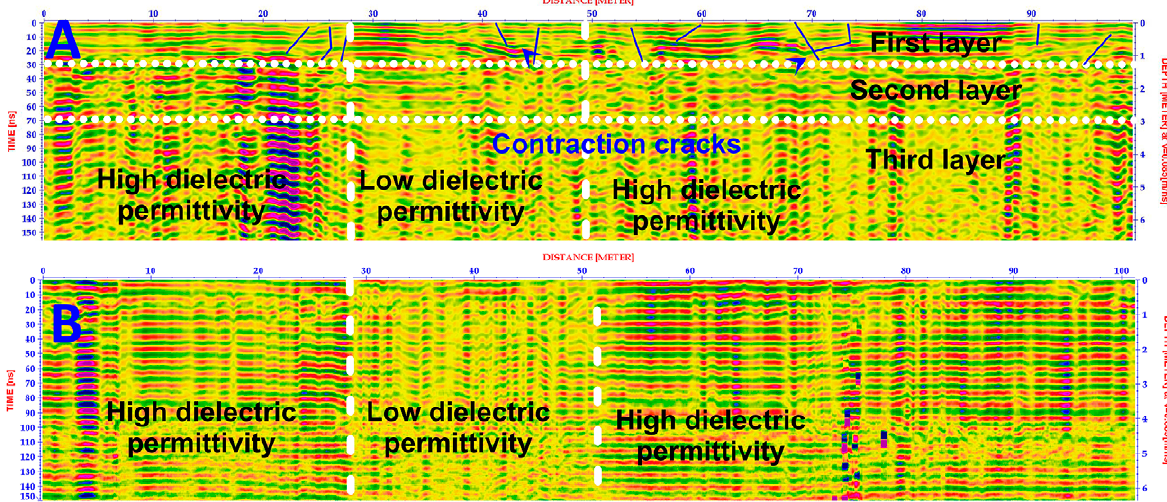
Figure 3. Interpretation and comparison of 100 m GPR profiles made by A) 200 MHz and B) 80 MHz antennae along the same survey line (16.2-16.1